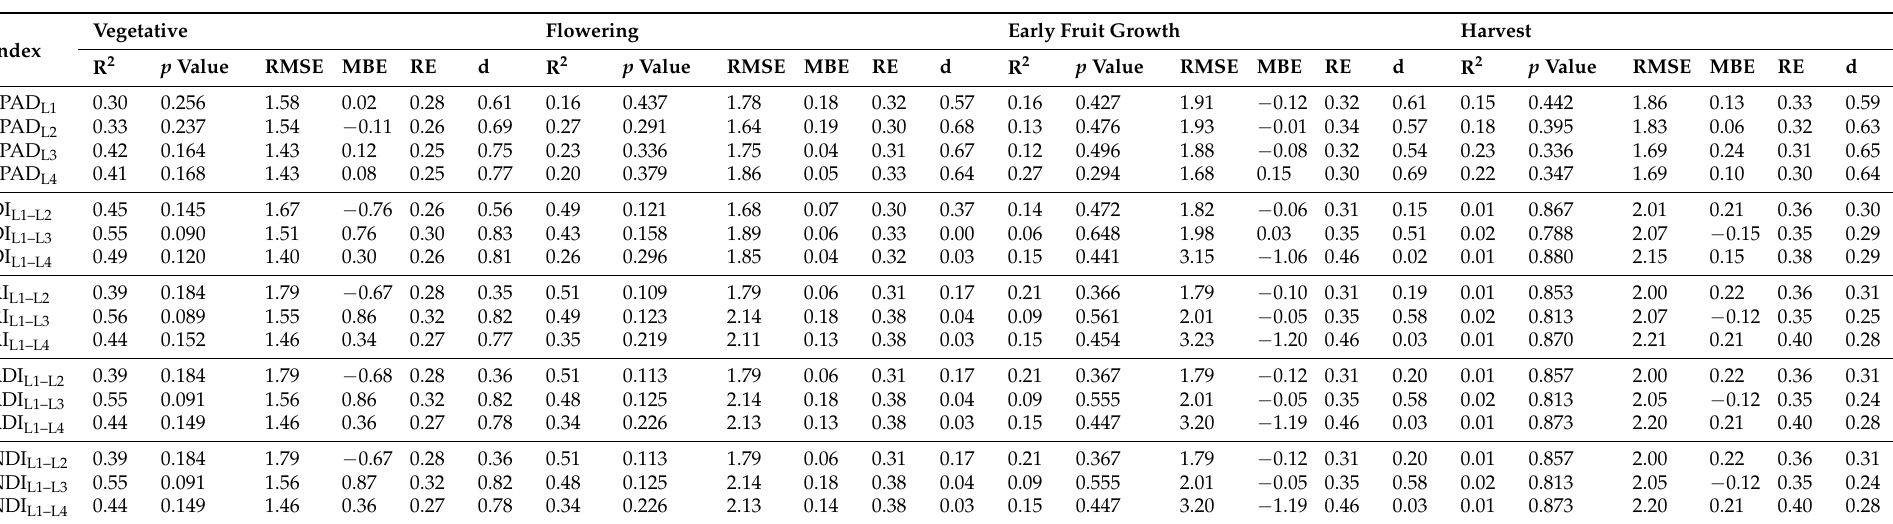
Table 6. Results of the validation analysis of the estimated fruit yield (kg m − 2 ) from SPAD measurements and several normalized SPAD indices (DI, RI, RDI, NDI), at different phenological stages of muskmelon. DI, Difference Index; RI, Relative Index; RDI, Relative Difference Index; NDI, Normalized Difference Index, R 2 , coefficient of determination; RMSE, root mean square error; RE, relative error; MBE, mean bias error; d, Willmott Index. L 1 , L 2 , L 3 and L 4 , refer to the latest (most recent), second, third and fourth fully expanded leaf,